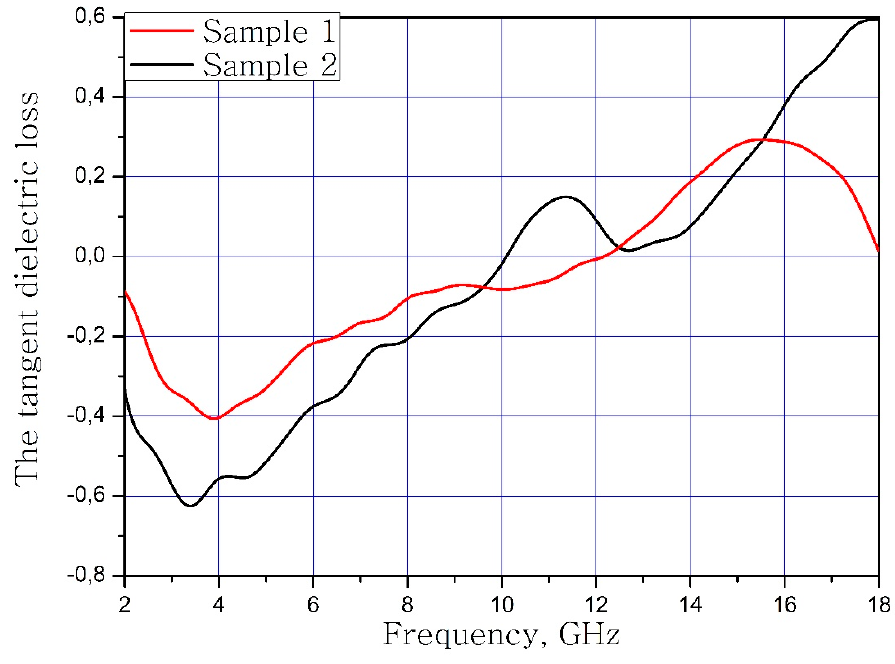
Figure 6. Frequency dependence of the imaginary part of magnetic permeability of samples.